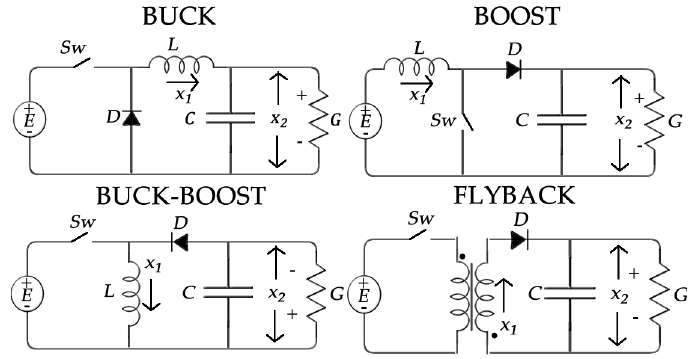
Figure 2. Basic power converters circuits.